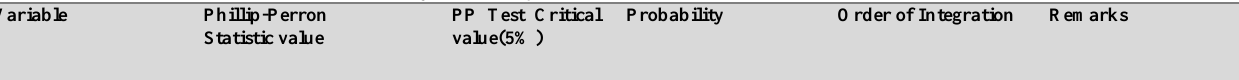
Summary of Phillip-Perron(PP) Unit Root Test